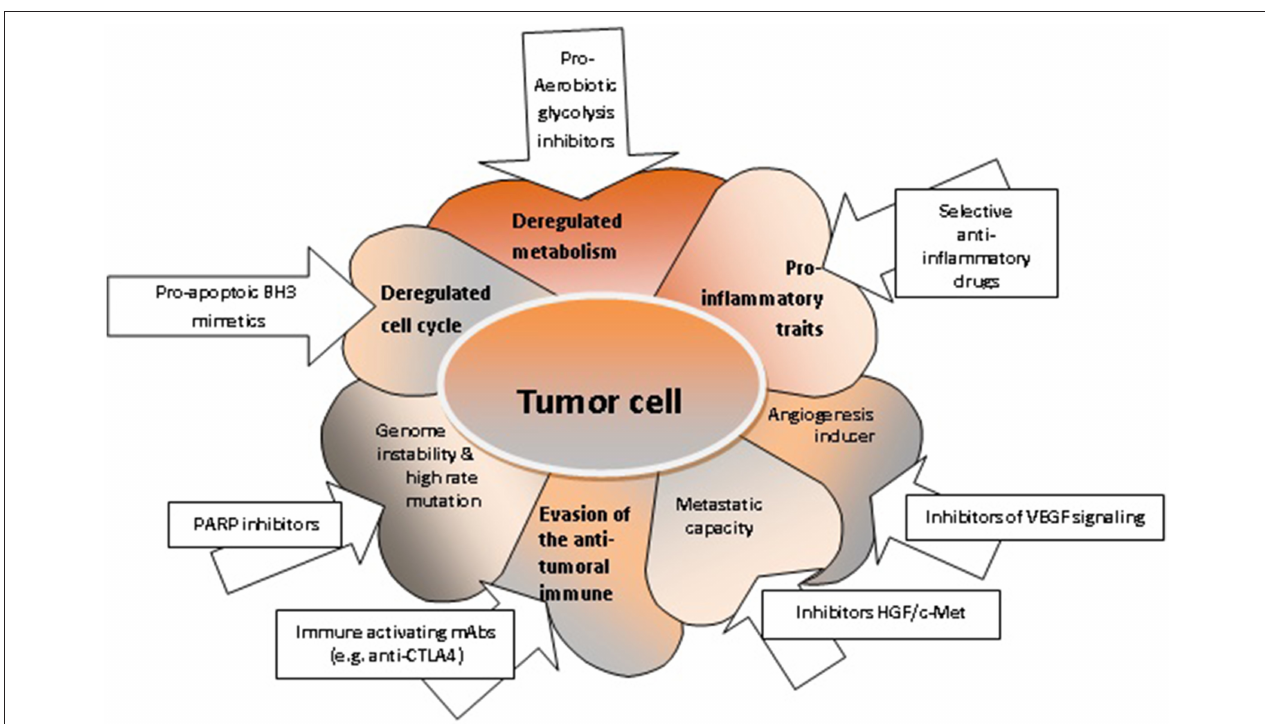
FIGURE 2 | The characteristics of tumor cells and respective targeted therapies. Deregulated metabolism can be targeted with pro-aerobiotic glycolysis inhibitors (52); deregulated cell cycle and increased uncontrolled cellular proliferation can be targeted with pro-apoptotic BH3 mimetics (76, 127); acquired genome instability can be targeted with PARP inhibitors ( 164); the evasion mechanisms of tumor cell from the anti-tumoral immune response can be controlled by immune activating mAbs ( 165); enhanced migration capacity of the tumor cell can be targeted with inhibitors HGF/c-Met (166); the angiogenic capacity can be shunted using inhibitors for VEGF signaling; pro-inflammatory properties of the tumor cell can be hindered by selective anti-inflammatory drugs